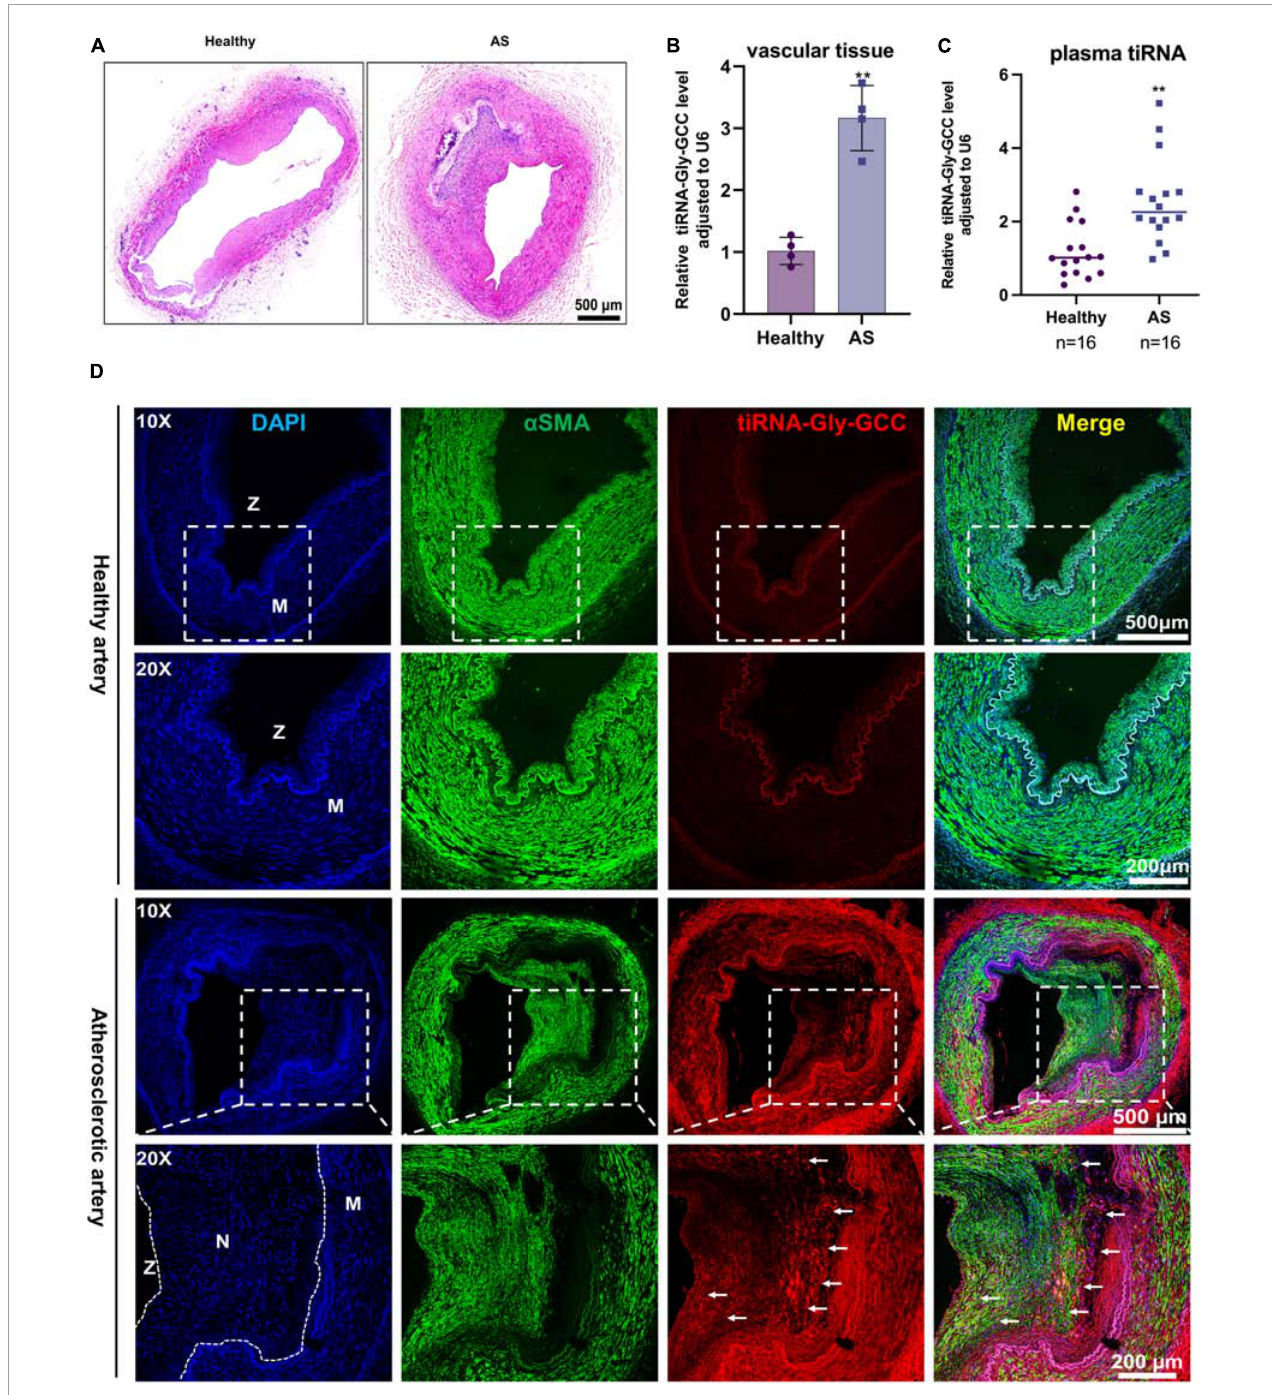
FIGURE2 The tiRNA-Gly-GCC expression pattern in human atherosclerotic vascular tissues and plasma. (A) Representative HE staining of healthy and atherosclerotic arteries. n = 4; scale bar, 500 µ m. (B) qRT-PCR analysis of tiRNA-Gly-GCC expression in healthy and atherosclerotic arteries (AS). Data are presented as the mean ± SD. n = 4, **p < 0.01. (C) tiRNA-Gly-GCC was analyzed by qRT-PCR in the plasma from healthy adults and patients with atherosclerosis, normalized to U6. Data are presented as the mean ± SD. n = 16 for each group, **p < 0.01. (D) Representative RNA-FISH and immunofluorescence staining of healthy and atherosclerotic arteries were selected from three group figures. tiRNA-Gly-GCC (red, cy3 labeled); α -SMA (green, 488-labeled); and DAPI (blue, labeled nucleus). The upper panel refers to healthy and the lower panel to atherosclerotic arteries. Scale bar, 500, 200 µ m. N, neointimal; M, media of vascular; Z, zoom of